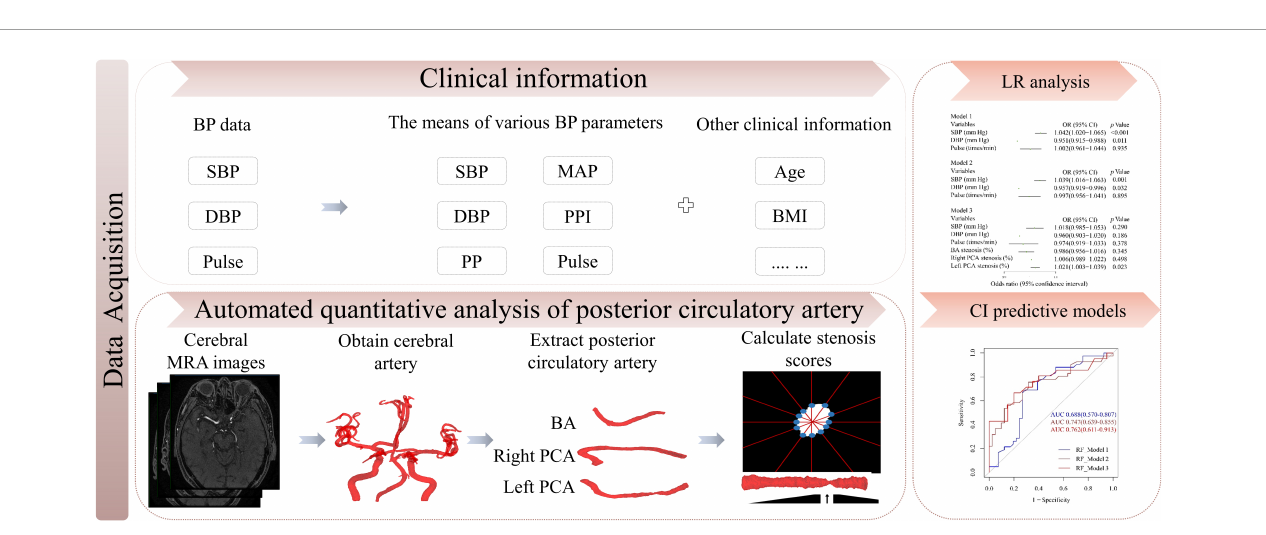
(Omron Healthcare, Inc., Kyoto, Japan) with the participant in a supine position. SBP, diastolic blood pressure (DBP) and pulse values measured during follow-up were averaged. PP was calculated as SBP- DBP, mean arterial pressure (MAP) was calculated as DBP + PP/3